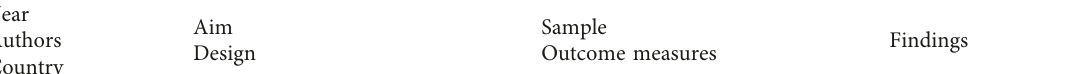
Table 3: Summary of relevant studies on escalating care to deteriorating